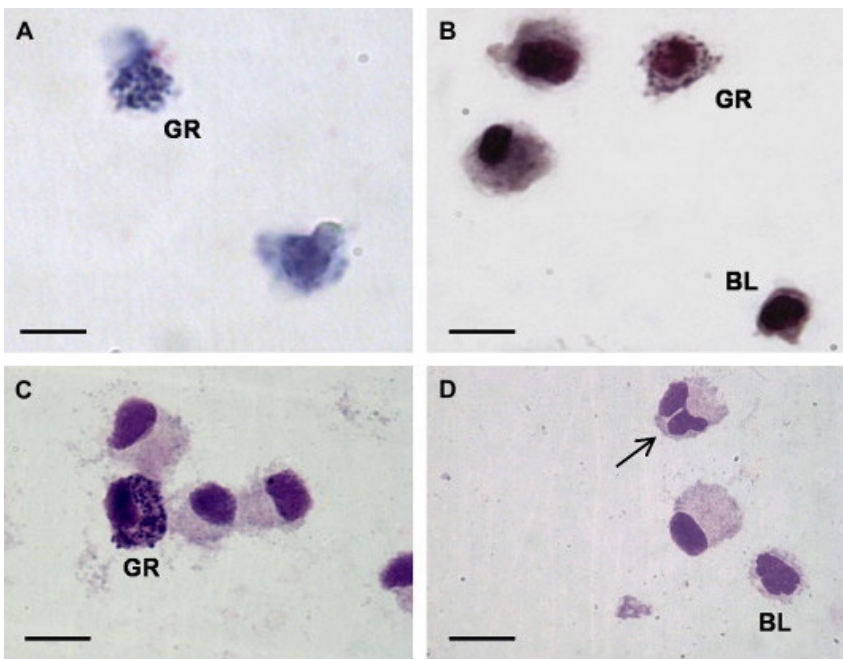
Figure 4. Light micrographs of hemocytes of the gastropod H. tuberculata ( A ). Hemocytes stained with Giemsa ( B ). Hemocytes stained with MGG ( C , D ) [14]. GR, granulocytes; BL, blast-like cell. All other cells are large hyalinocytes. Take notice of the bilobulated nucleus (arrow).